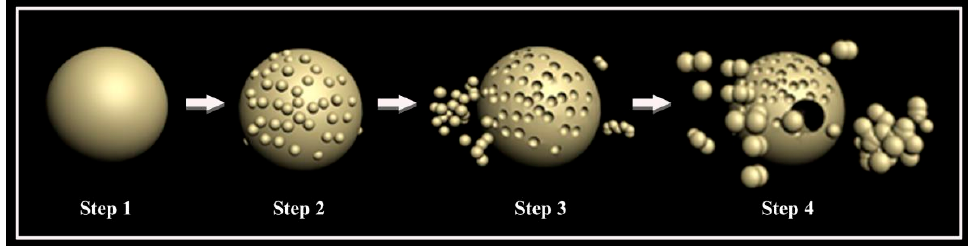
Figure 8. Degradation curves of the methylene blue solution under the different BiVO 4 degradation conditions. -40 -20